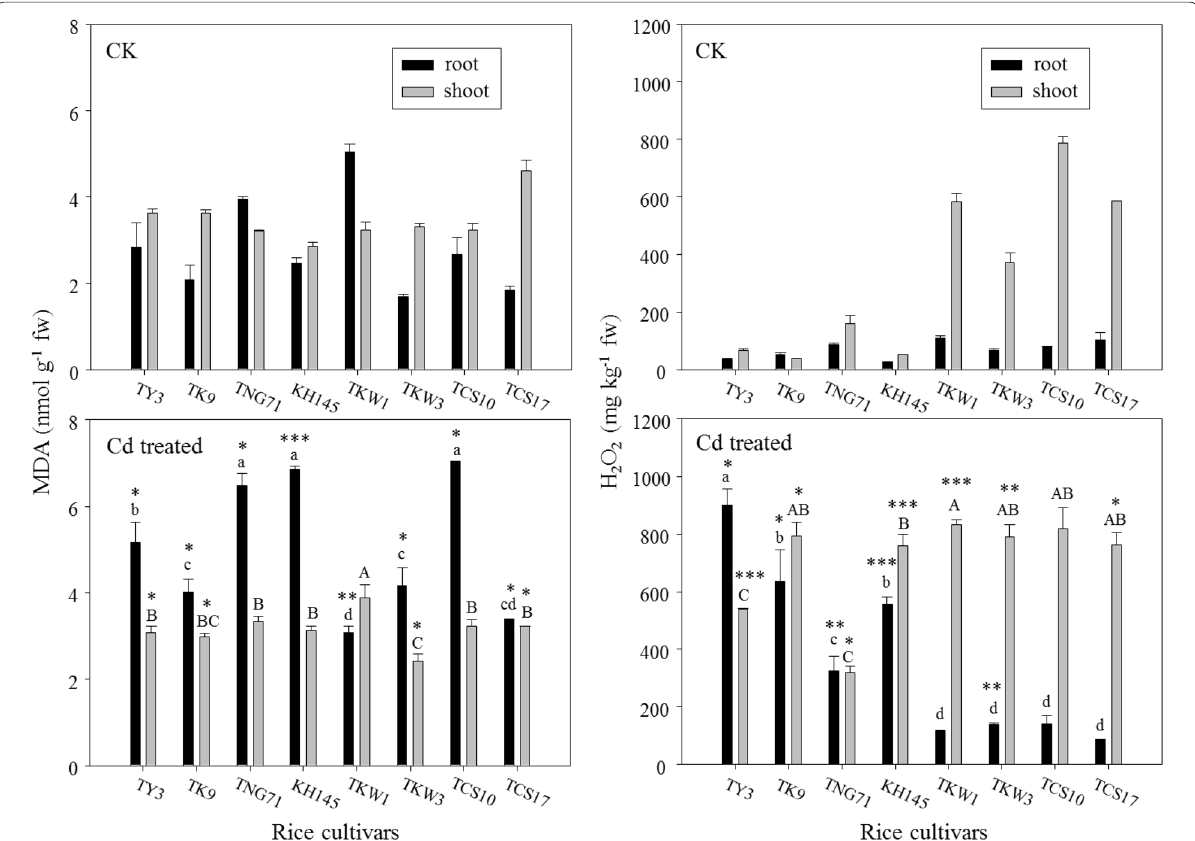
Fig. 3 Concentrations of malondialdehyde (MDA) and H 2 O 2 in root and shoot for the rice seedlings after a 7‑day exposure of 50 μM Cd (Cd treated) and a check (CK) of the cultivars, TY3, TK9, TNG71, KH145, TKW1, TKW3, TCS10, and TCS17. Error bars represent the standard errors of the mean values (replicates n 3). Same lowercase letters above the black bars or same capital letters above the gray bars indicate the mean values are not = significantly different at p < 0.05 among the cultivars according to the last significant difference (LSD). *, **, and *** indicate significant differences at p < 0.05, p < 0.01, and p < 0.001 between Cd treated and CK by the